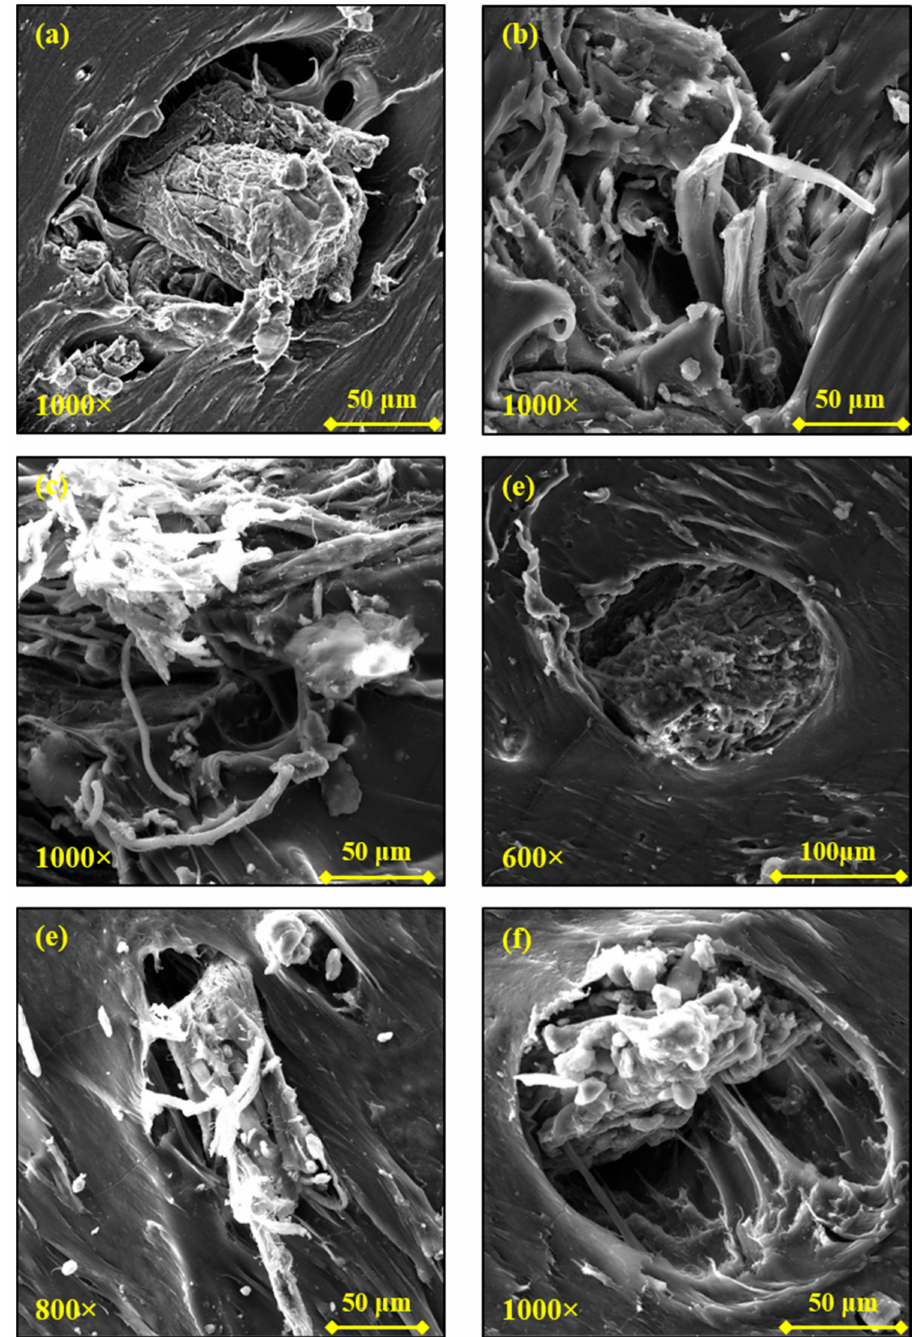
Figure 8. Scanning electron microscope (SEM) images of the PA1210WB ( a , b ), TPU10WB ( c , d ), and TPE10WB ( e , f ) samples at different